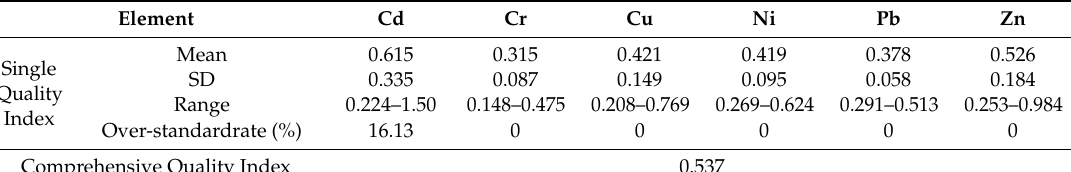
Table 4. The single and comprehensive quality indices for HMs in greenhouse soils in